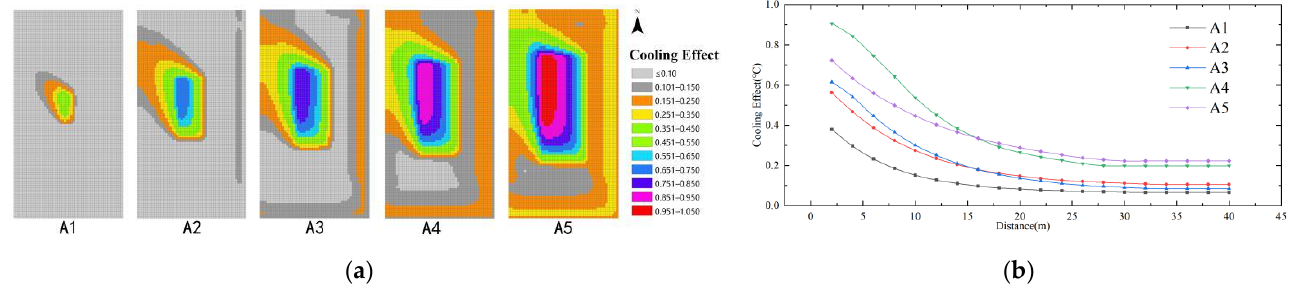
Figure 12. Cooling effect of water body area index: ( a ) Impact distribution map; ( b ) Impacts with distance.